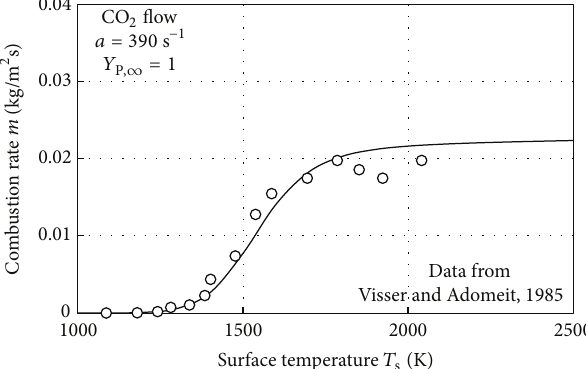
Figure 2: Combustion rate of the graphite hemisphere in CO 2 -flow with the velocity gradient of 390s −1 , as a function of the surface temperature. Data points are experimental [34] and the curve is calculated from the theory in